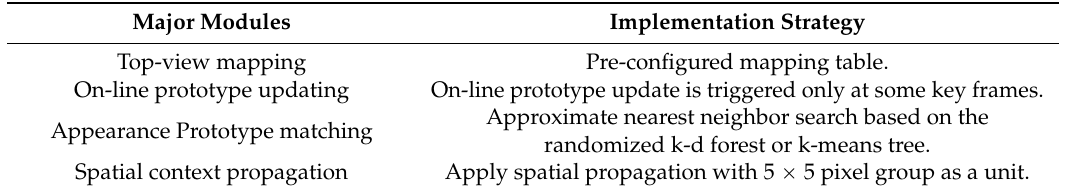
Table 3. Some implementation strategies in the far-field model.